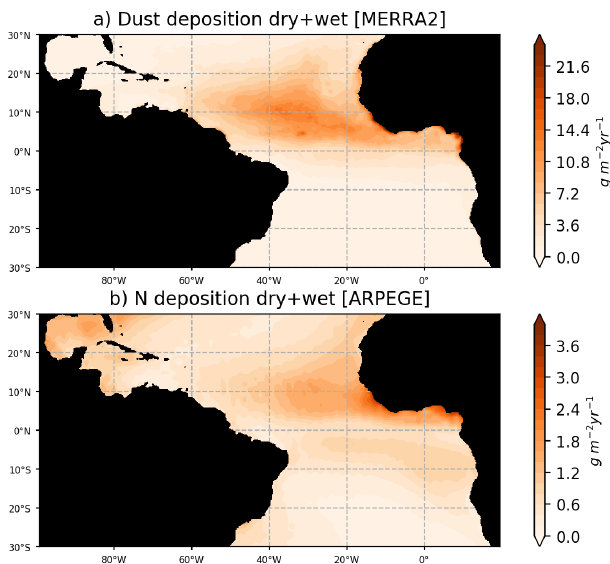
Figure 2. Dust fluxes to the ocean from MERRA2 reanalysis for the year 2017 (a) and nitrogen flux to the ocean from ARPEGE simula- tions averaged over the period 2010–2014. Nitrogen fluxes consider the dry and wet fluxes at the ocean surface of NO 3 , NH 4 , and NH 3 . Dust fluxes consider the total dust dry-plus-wet deposition product (DUDPWTSUM) from